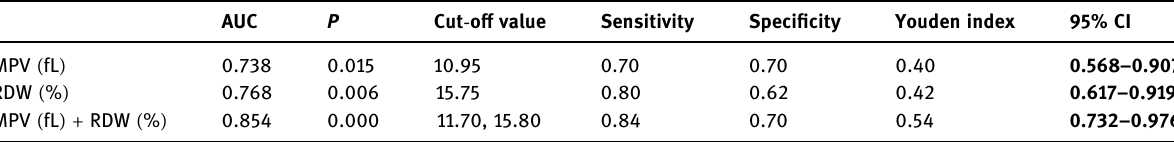
MPV, mean platelet volume; RDW, red blood cell distribution width.